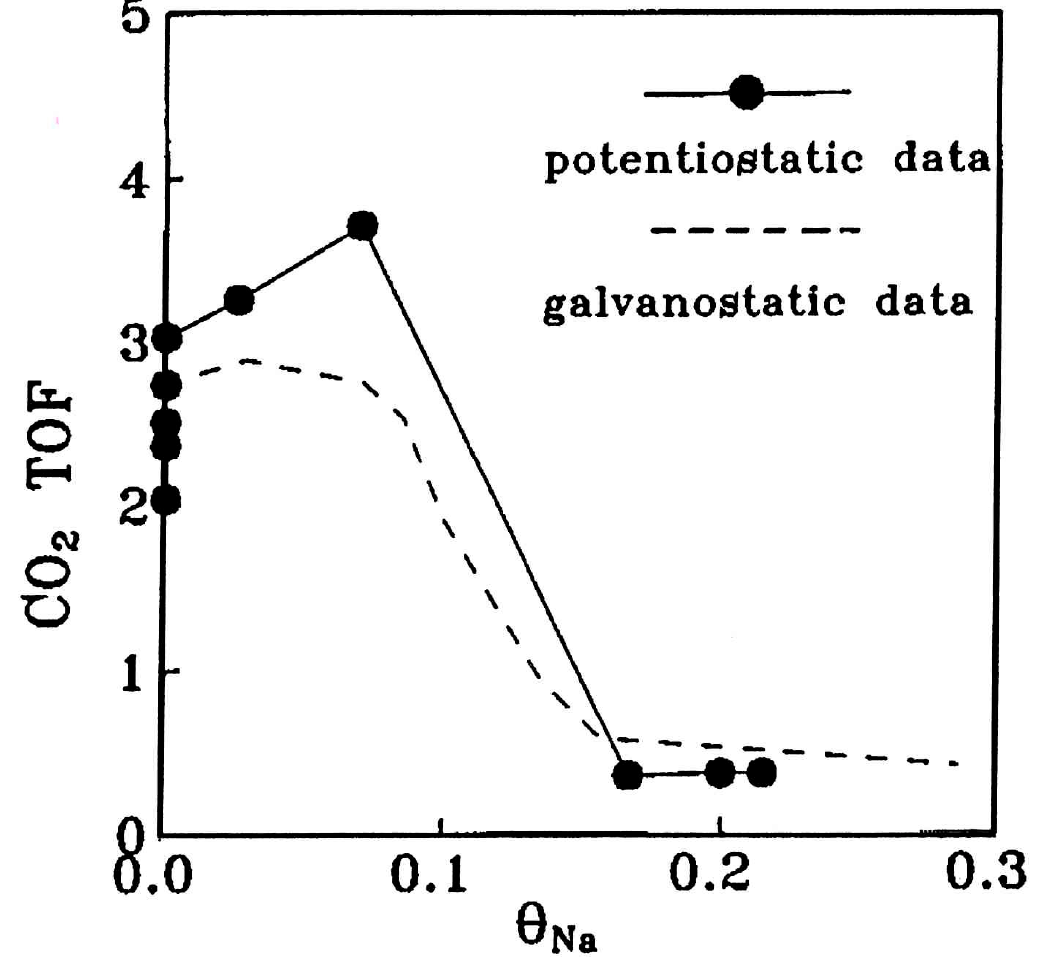
Figure 7. Rate as a function of Na coverage for both potentiostatic and galvanostatic experiments for [O 2 ] = 8.0% [C 2 H 4 ] = 4.2% (balance He) mixture at 352 °C. Data was acquired in